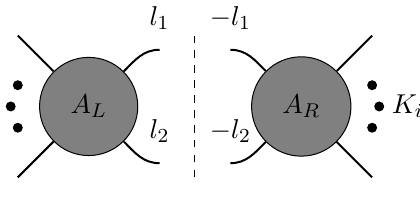
Figure 1 . K i -channel double